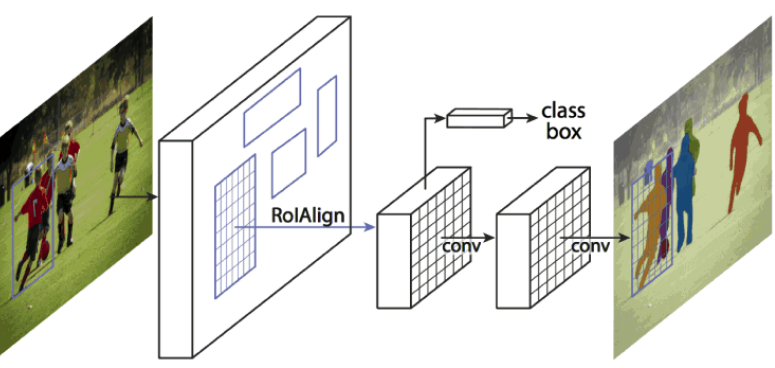
Figure 2. Mask R-CNN framework. (Figure 2 was taken from the Mask R-CNN paper